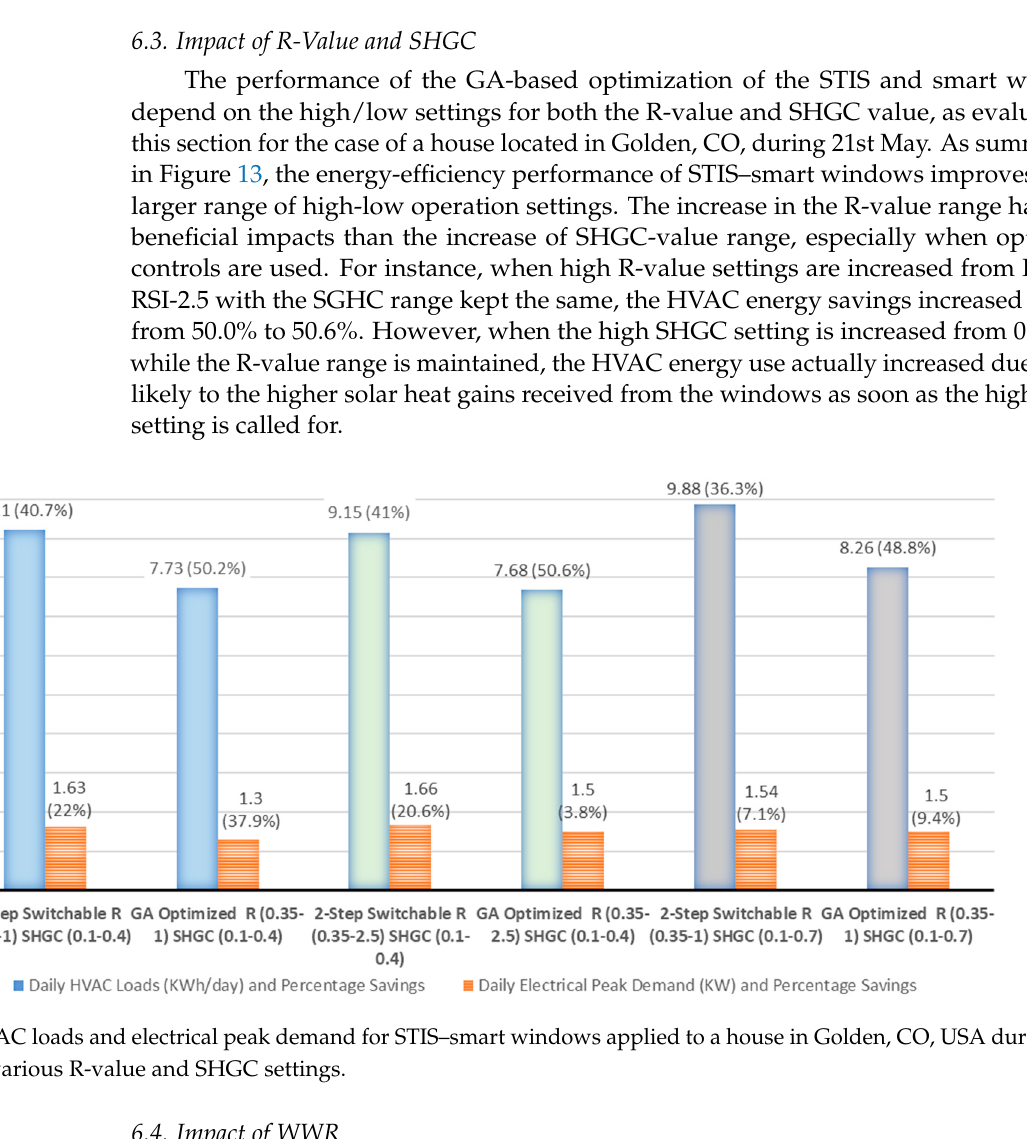
Table 13. Impact of population size on GA optimization results for STIS–smart windows applied to a house located in Golden, CO, during 21st May.